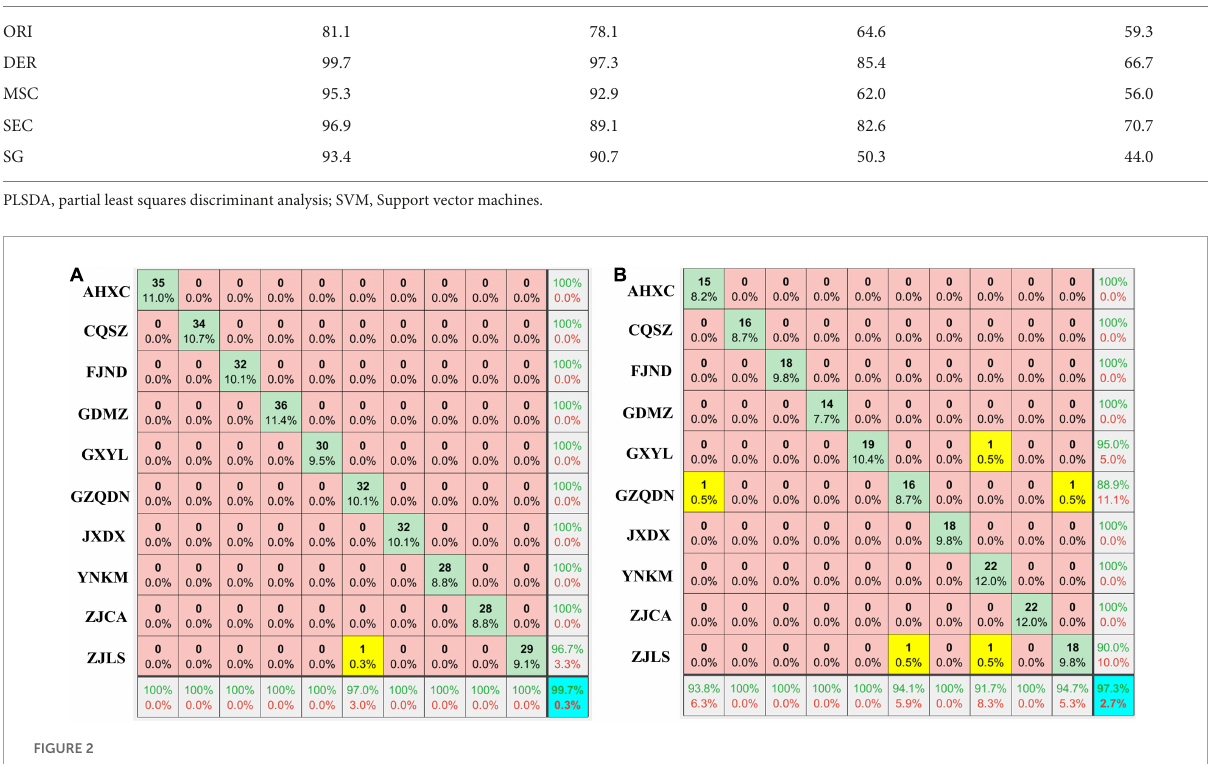
JXDX vs. CQSZ, JXDX vs. GXYL, JXDX vs. GZQDN, and